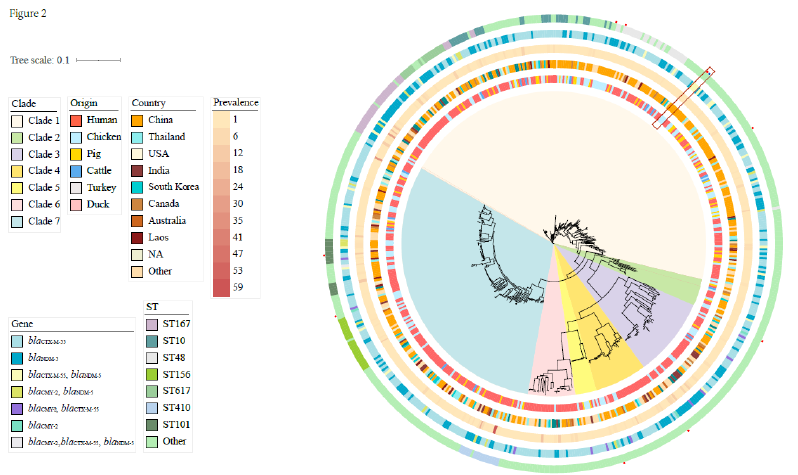
Figure 2. Phylogenetic analysis of the representative ceftiofur ‐ resistant E. coli from this study and GenBank. Origins, countries, prevalence, ceftiofur resistance genes and ST types of the isolates are indicated from the inner to outer ring. Red dots represent the isolates from this study and the blue dot represents the isolates from GenBank that share <35 SNPs with an isolate in this study.